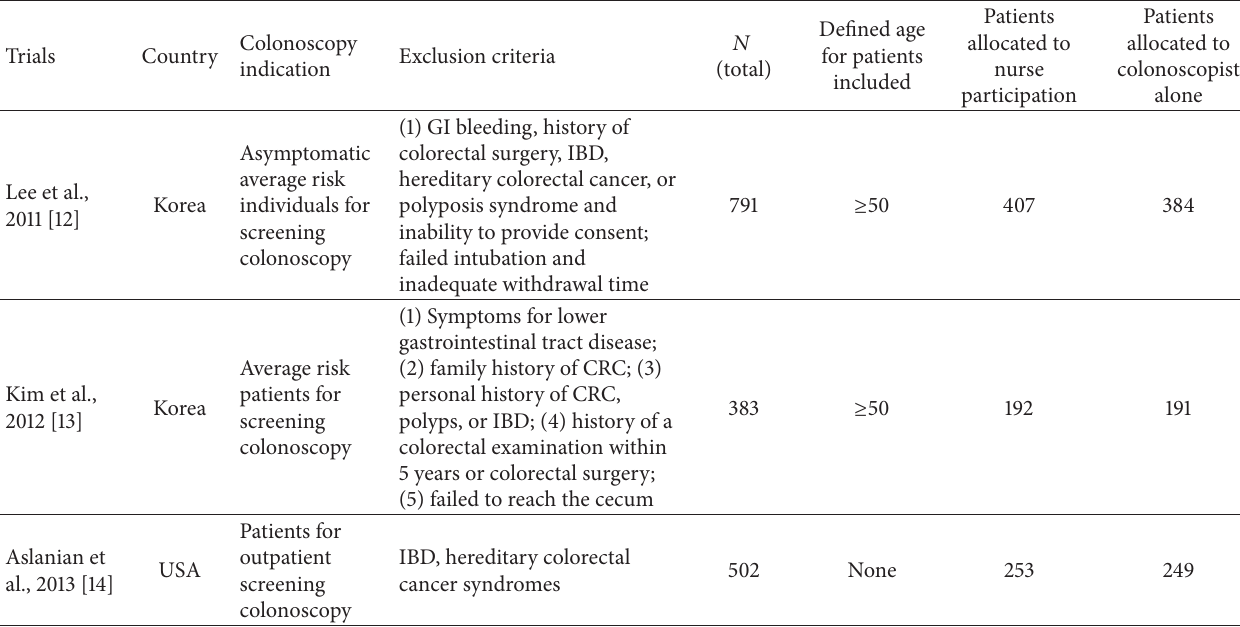
Table 1: Characteristics of included randomized controlled trials.